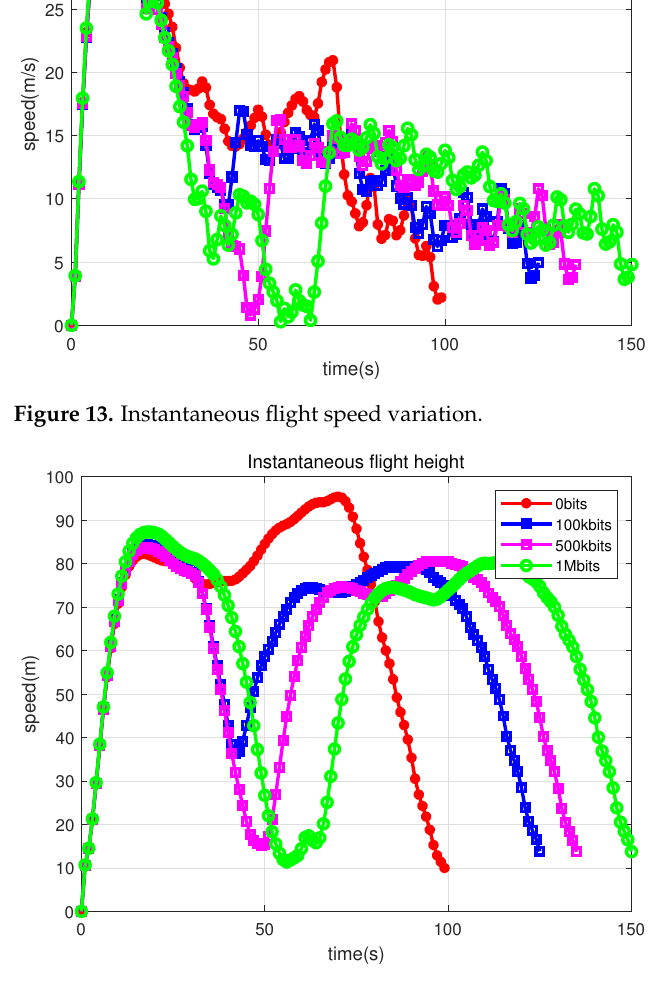
Figure 14. Instantaneous flight